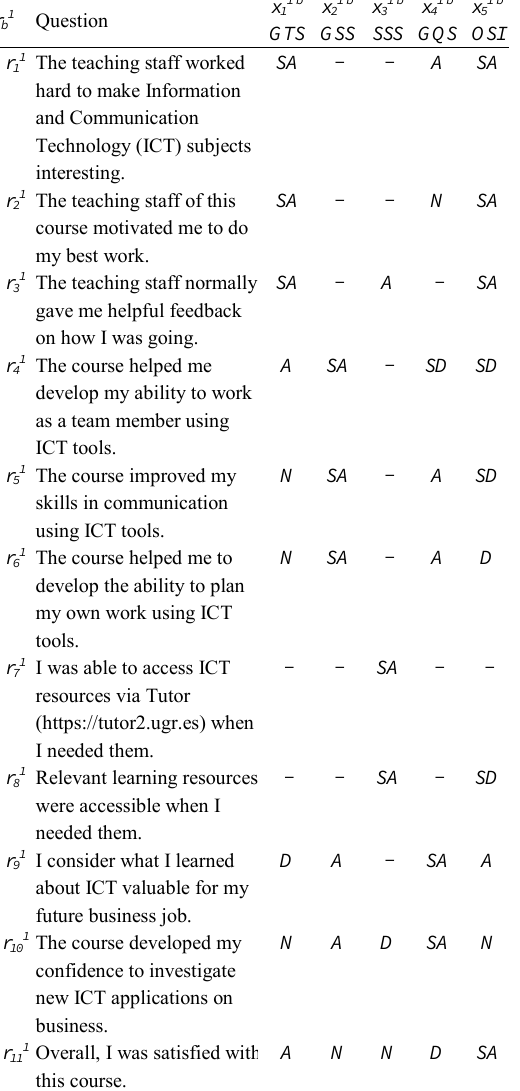
Table 2. Result of the LMCDM process to associate the input questions of R 1 with the CEQ scales ( X Cab ).